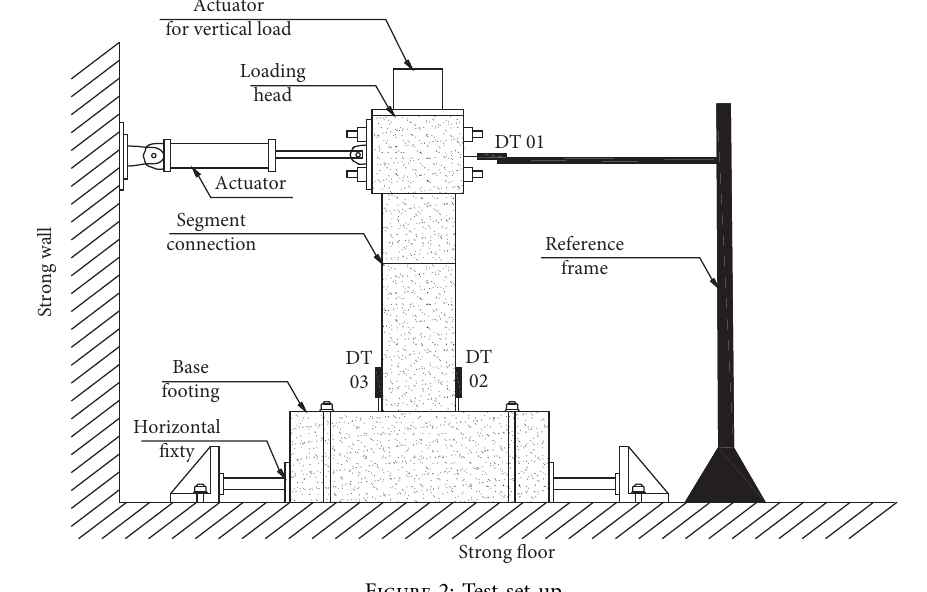
Figure 2: Test set-up.